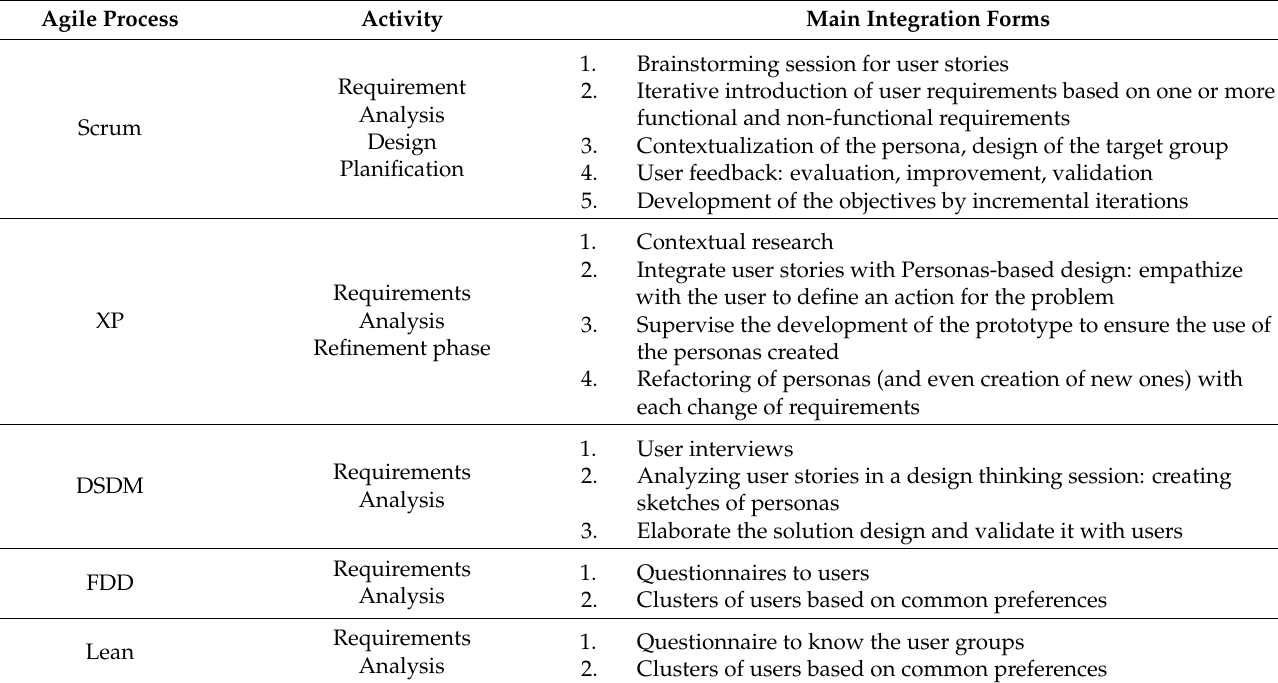
Table 7. Main integration forms for each type of agile process (answer to